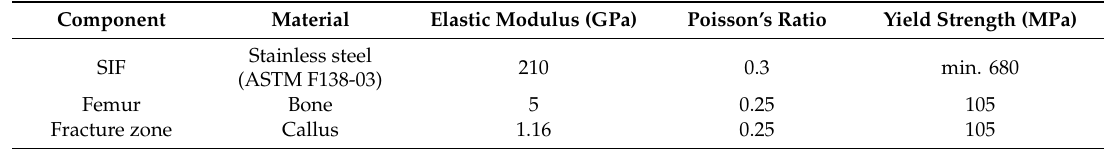
Table 1. Linear material model parameters of the femur–SIF assembly components.